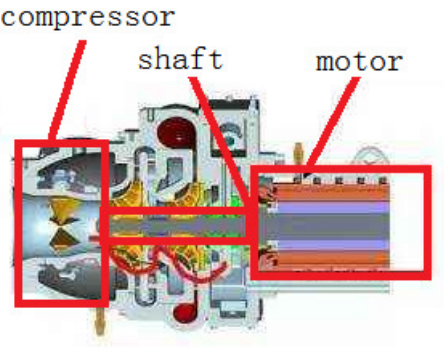
Figure 1. Compressor powered by a super high-speed PMSM. Table 1. Parameters of two-mass system.